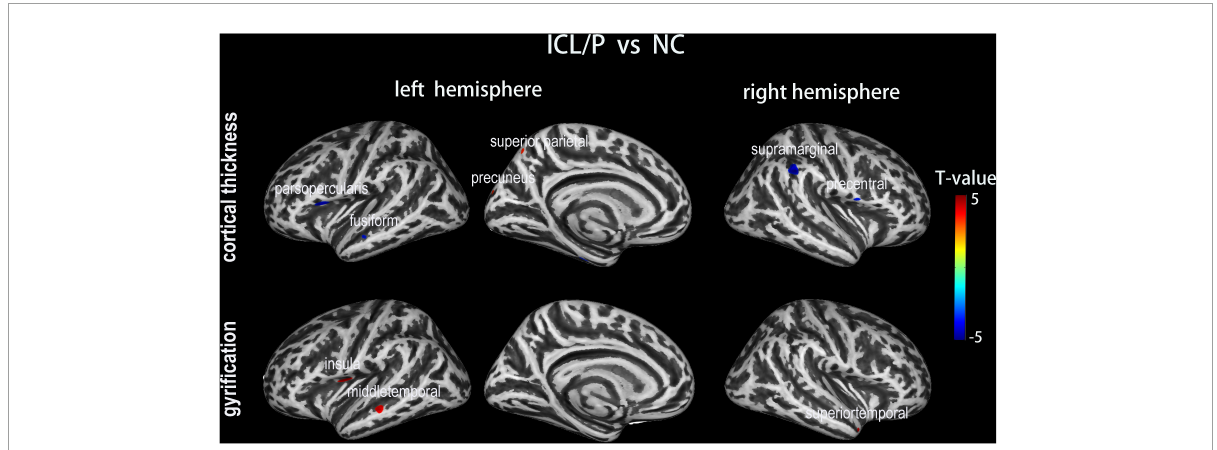
FIGURE1 Altered cortical thickness (CT) and gyrification between the isolated clefts of the lip and/or palate (ICL/P) group and normal controls (NC). A two-sample t -test was used; statistical significance was p < 0.001, uncorrected. Color bars indicate T-values. The 3D inflated brain maps show the spatial location of intergroup different regions, shown on lateral or medial views.